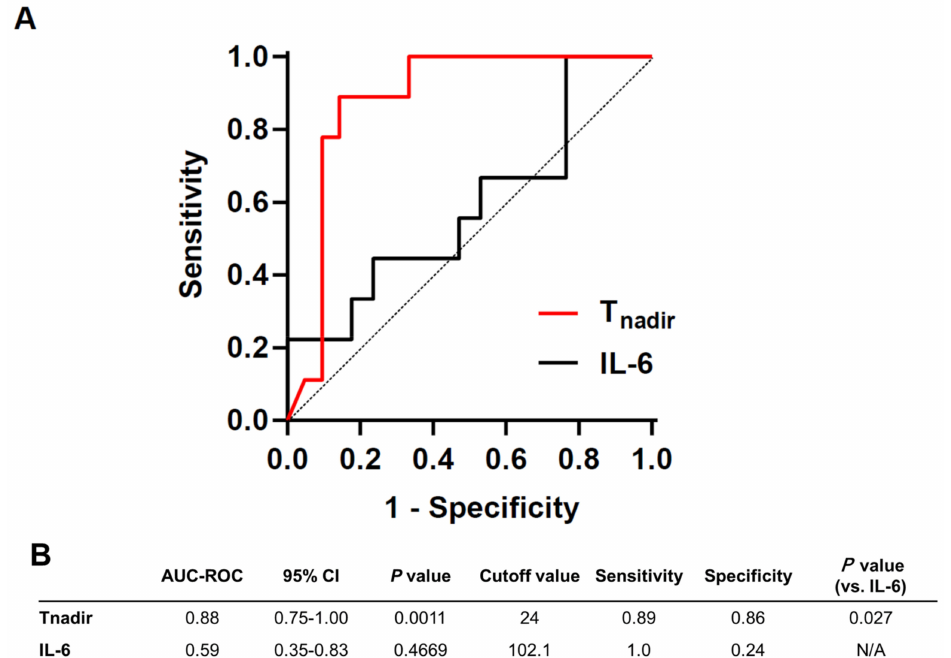
Figure 7. ROC analyses. ( A ) The ROC-AUC revealed that a T nadir cut-off of 24 min provided optimal sensitivity and specificity for predicting good neurological outcomes (AUC, 0.88; 95% CI, 0.75–1.0; sensitivity, 88.9%; specificity, 85.7%; p = 0.001). ( B ) The AUC of plasma IL-6 levels at 1 h after return of spontaneous circulation, for predicting good neurological outcomes, was 0.59 (95% CI, 0.35–0.83; p = 0.47). The AUC of T nadir was significantly superior to that of plasma IL-6 ( p = 0.027). AUC: area under the curve, CI: confidence interval, IL-6: interleukin